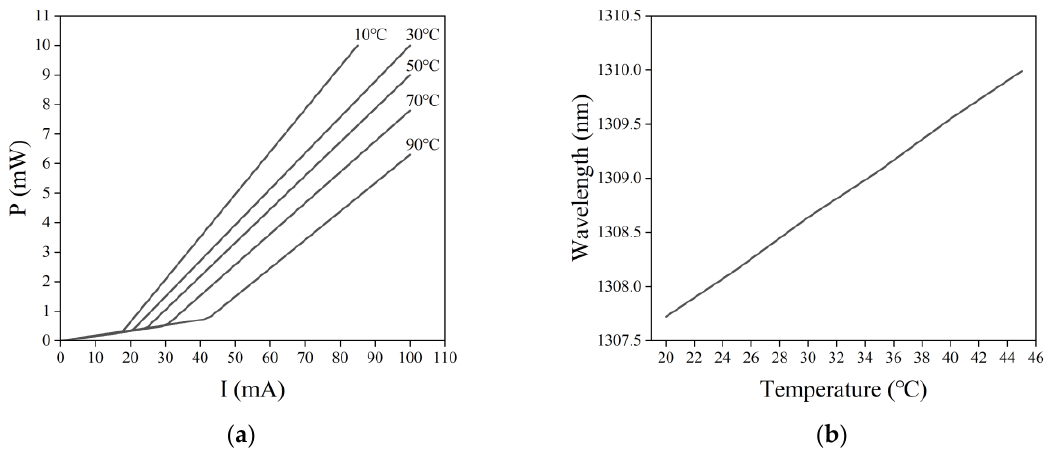
Figure 2. Temperature characteristics of semiconductor lasers. ( a ) Temperature effect on the P-I characteristic curve. ( b ) Temperature effect on the output wavelength.